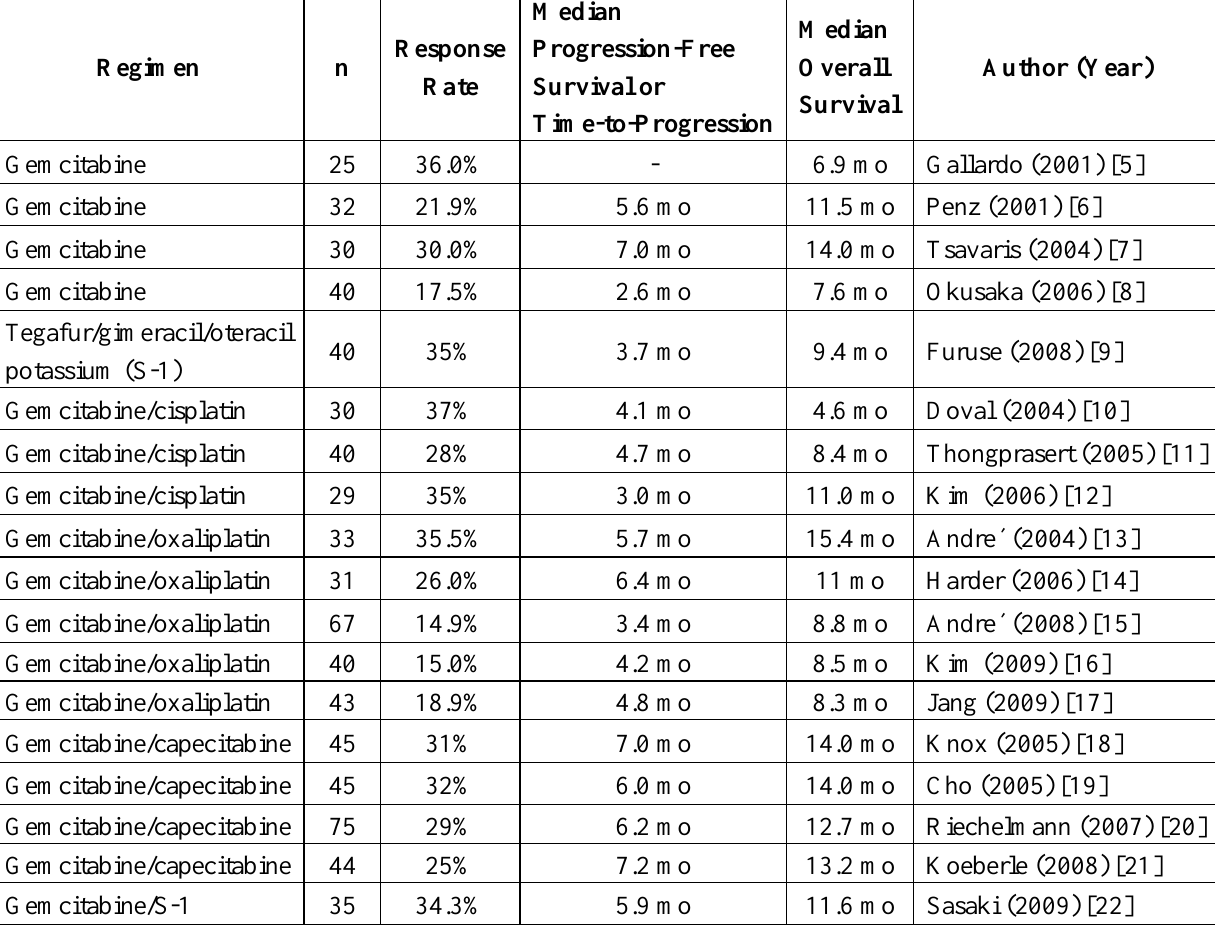
Table 1. Phase II studies of gemcitabine-based regimen for unresectable biliary tract cancer.